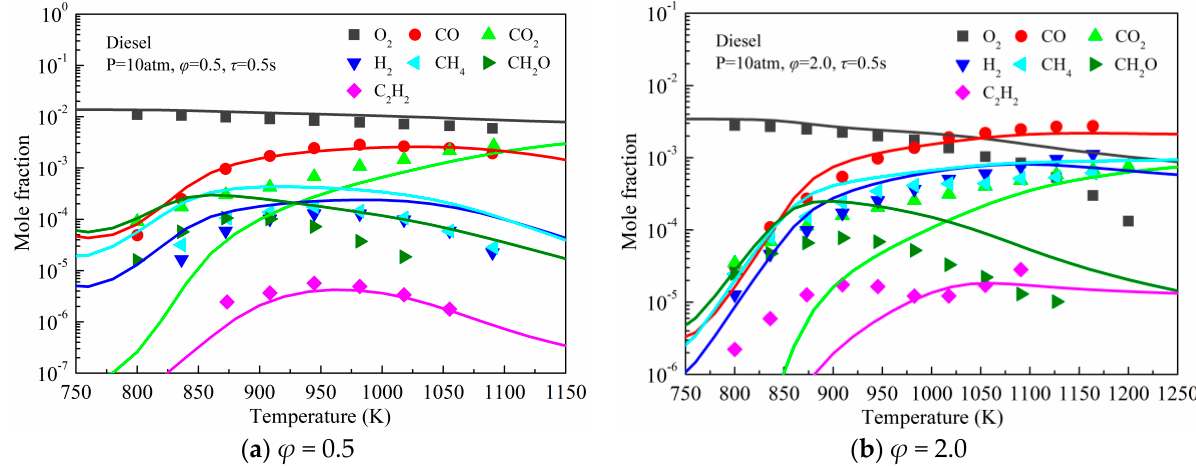
Figure 9. Measured (symbols) [36] and calculated (lines) species concentrations in a JSR for synthetic diesel fuel/air mixtures at 10 atm, τ = 0.5 s, ϕ = 0.5 and 2.0.